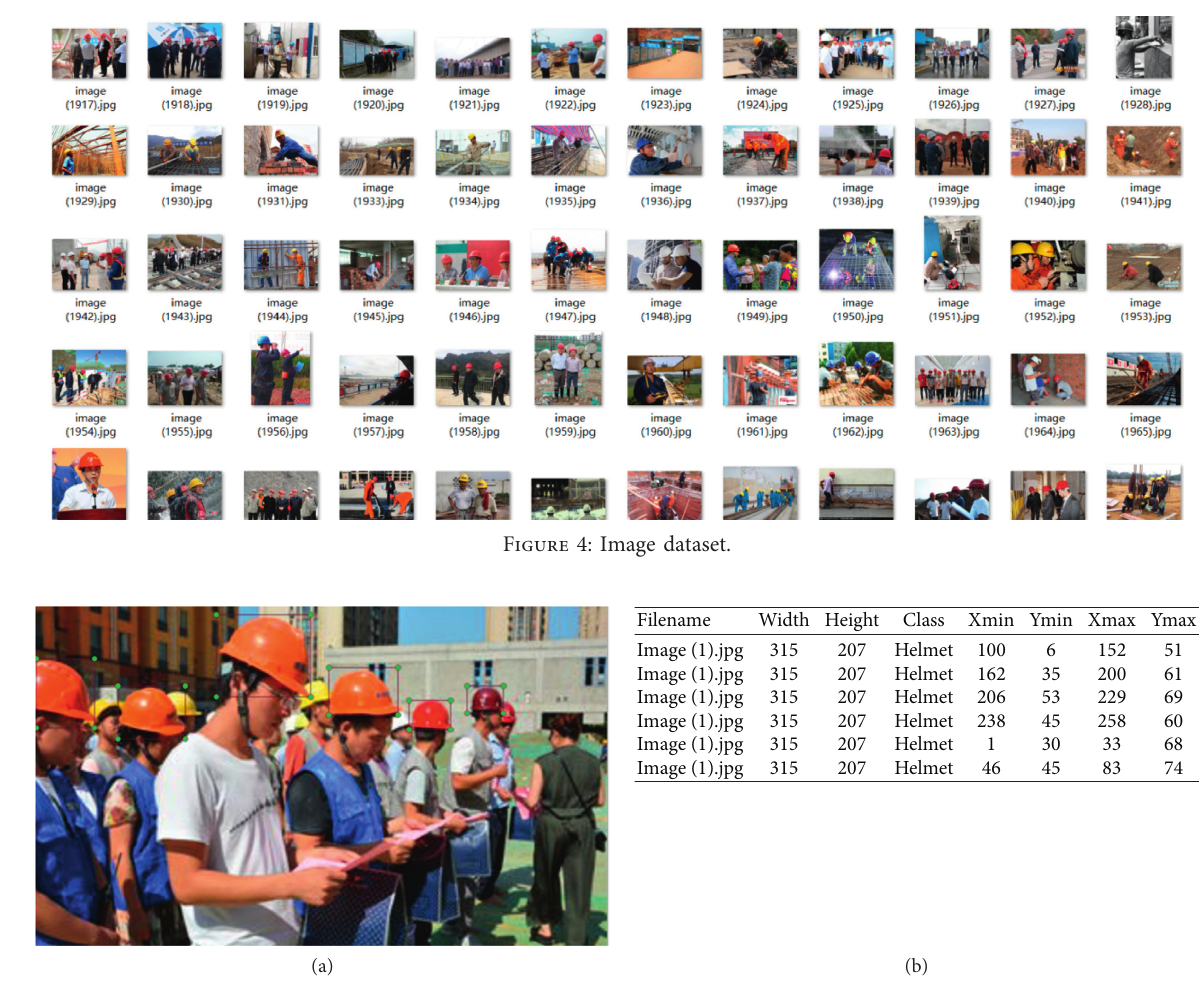
Figure 5: (a) Manual labeling. (b). Data